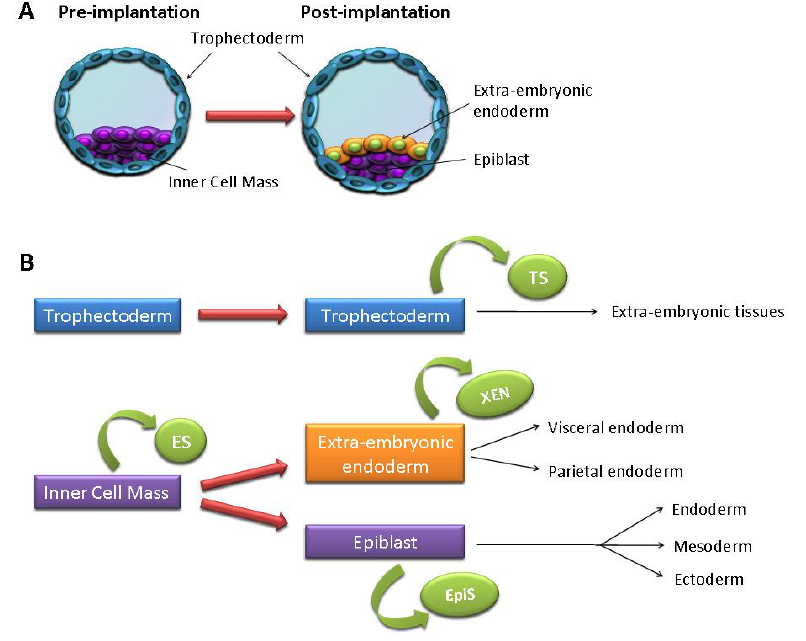
Figure 1. A generalized view of the derivation of stem cells from pre- and post-implantation stages. ( A ) Pre-implantation blastocysts (left) are formed by two different cell types; the external trophectoderm surrounds a cavity where the inner cell mass (ICM) is found. In post-implantation stages, the ICM differentiates into the epiblast (internal) and the extra-embryonic endoderm (in contact with the cavity); ( B ) List of cell types found in pre- and post-implantation stages and the relative stem cell lines that have been isolated and maintained in vitro (green). ES = Embryonic Stem cells from the ICM, TS = Trophoblast Stem cells from the trophectoderm, XEN = Extraembryonic endoderm-derived cells, EpiS = Epiblast Stem cells. The black arrows indicate the tissues that each cell type will develop into during